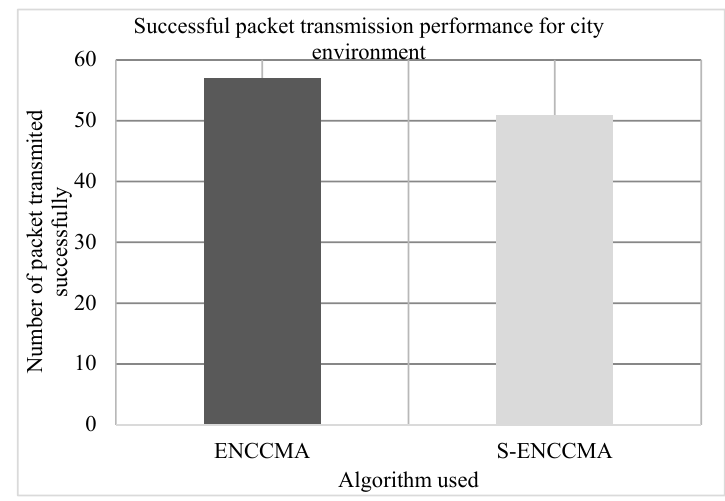
Figure 6. Successful packet transmission performance achieved for a city environment. Sensors 2020 , 20 , x FOR PEER REVIEW